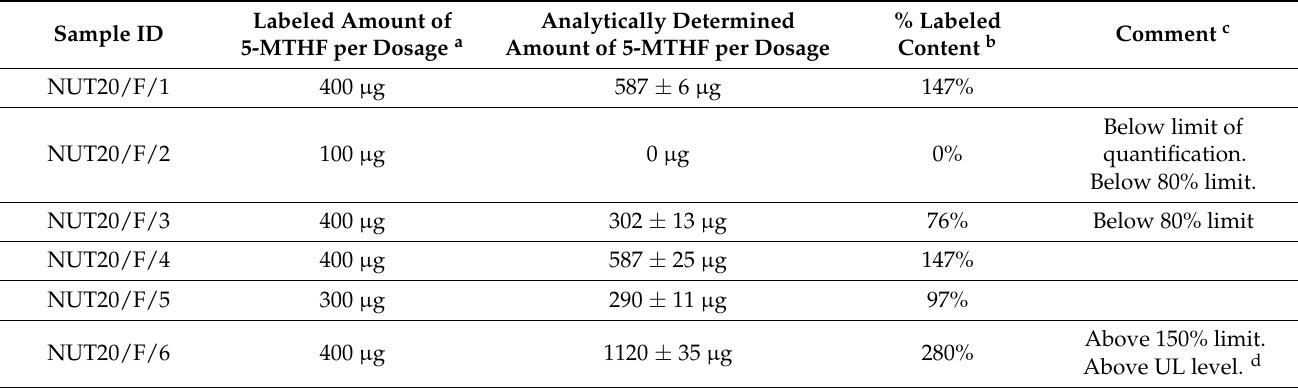
Table 1. Results of laboratory quantification of 5-methyltetrahydrofolate (5-MTHF) in sampled food supplements and conformity with regulatory